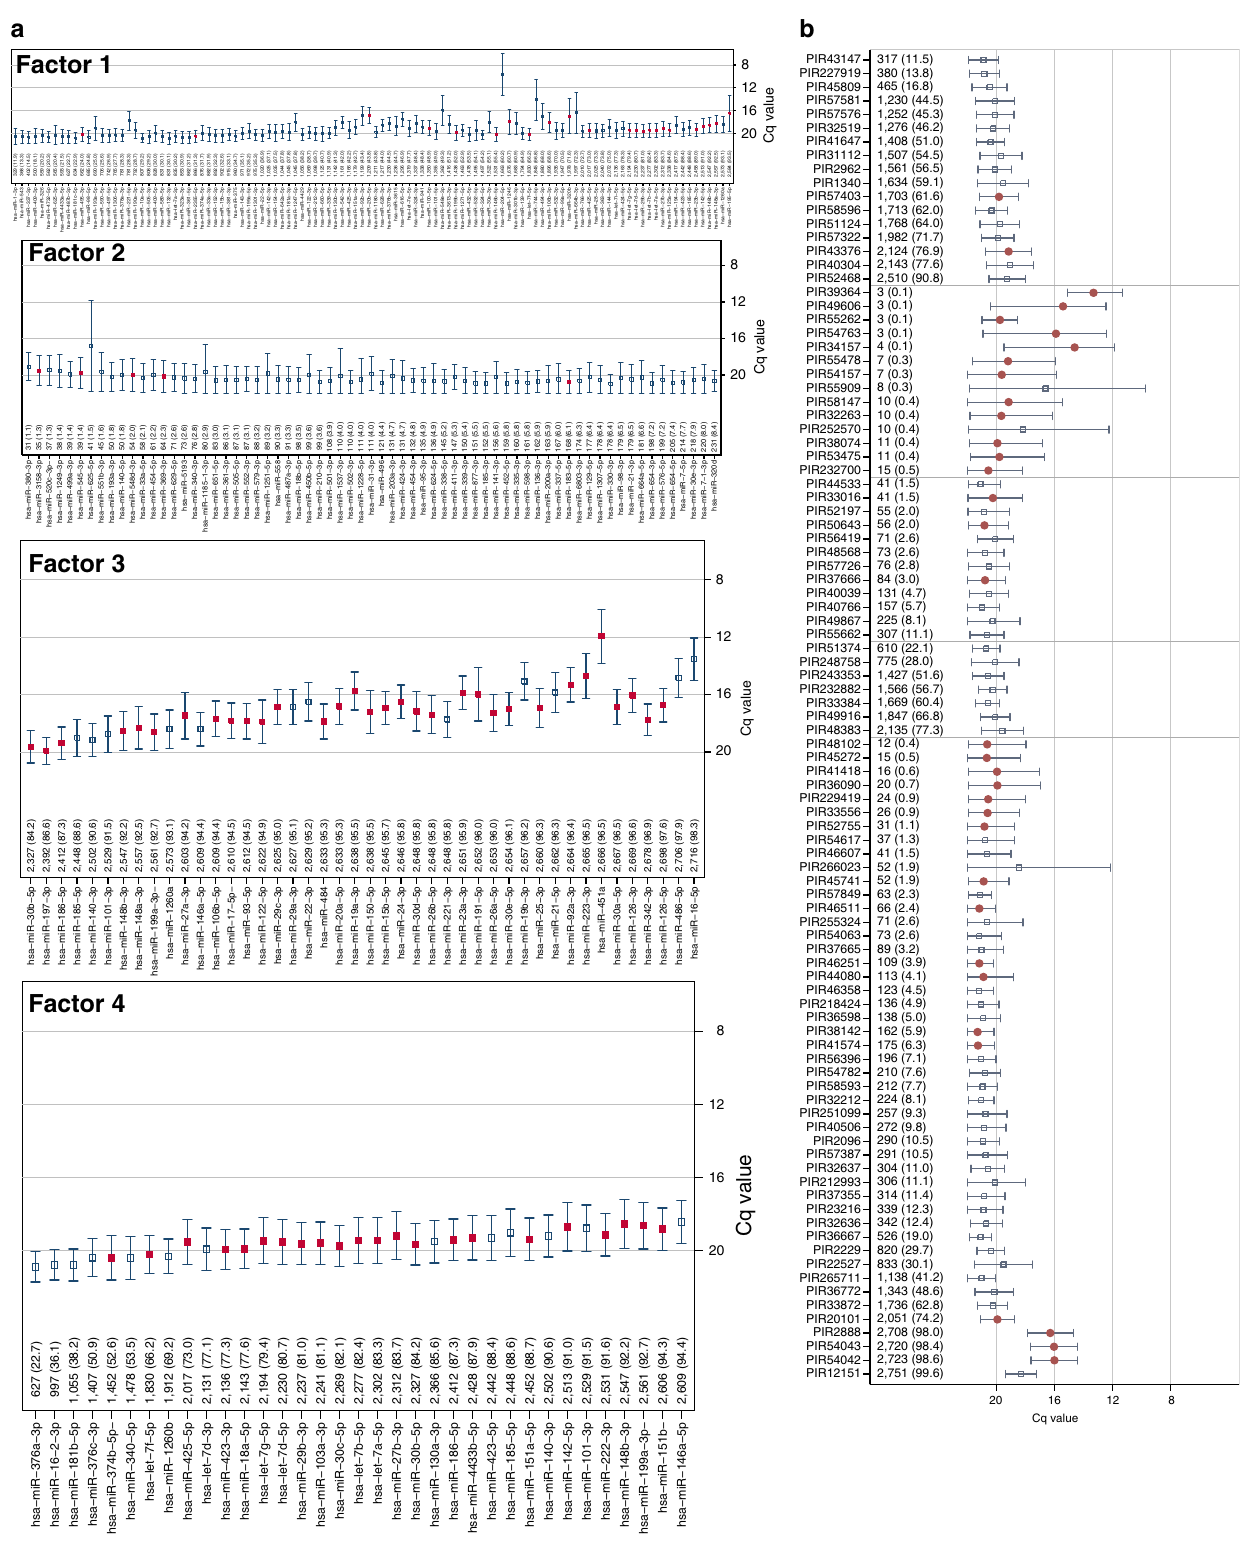
Figure 4 | Measurement of plasma miRNAs and piRNAs by RT-qPCR in 2,763 FHS participants. The prevalence and quantity of expression for each miRNA ( a ) and piRNA ( b ) are measured. RNAs are sorted from least to most expressed with the N and per cent expressed (that is, Cq o 23). The quantification cycle (Cq) axis is sorted in reverse order so that expression increases from bottom to top ( a ) or from left to right ( b ) along the axis. The mean ( ± s.d.) Cq values are depicted with the horizontal capped lines and small squares ( a , b ) or dots ( b ) for each RNA. Light horizontal grey gridlines stratify RNAs by per cent of expression at o 10% and 4 90%. Red squares or dots are used for statistically significant associations for age ( P o 0.05 after adjusting for multiplicity using the FDR) and navy squares are used for RNAs not meeting statistical significance. All supporting values included age and sex of participants are included in Supplementary Tables 1–3 and Supplementary Data